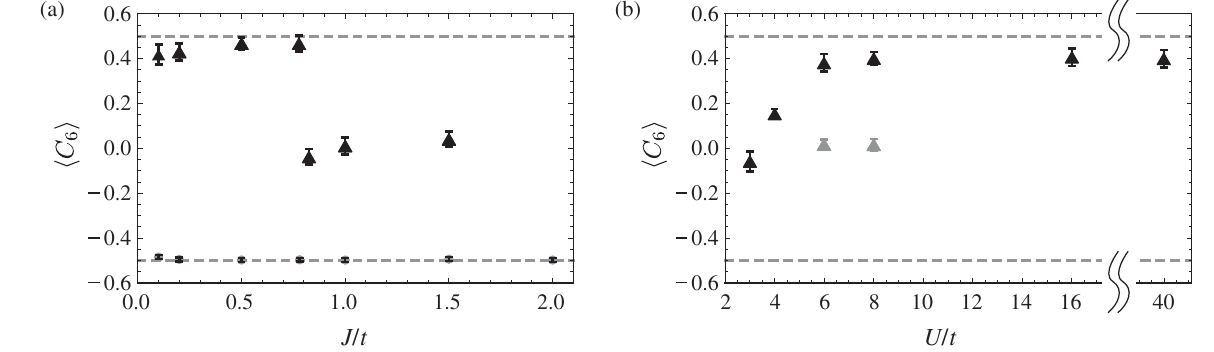
FIG. 9. Expectation value of 60-deg rotation operator ( C 6 ) in DMRG ground state: (a) t - J model on 32-site sample (triangles) with projection of wave function to center-of-mass momentum Γ , and on 24-site sample (disks) without projection. (b) Hubbard model on the 32-site sample, with (black triangles) and without (smaller gray triangles) projection to Γ momentum.